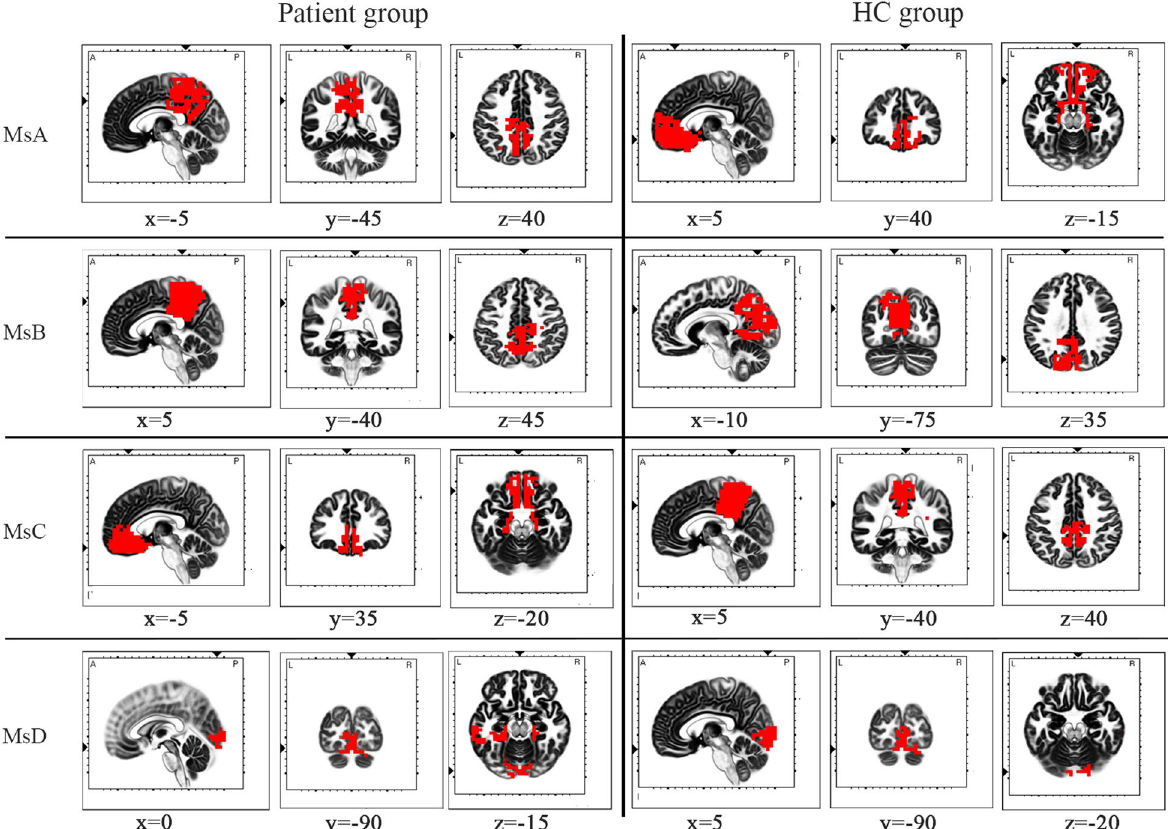
Fig.3 The eLORETA images of corresponding microstates shown in MNI brain for patient and control groups. The red color indicates the maximum current density (> 75%). The small triangles along the coordinate axes indicated the maximum electric neuronal activity and the corresponding peak coordinates were displayed in lower part of each intercepted image. The corresponding peak coordinates are displayed above each captured image. Microstates A to D in the patient group were in Cingulate Gyrus (BA31), Precuneus (BA7), Medial Frontal Gyrus (BA11), Lingual Gyrus (BA18). Microstates A to D in the control group were in Medial Frontal Gyrus (BA11), Precuneus (BA7), Cingulate Gyrus (BA31), Lingual Gyrus